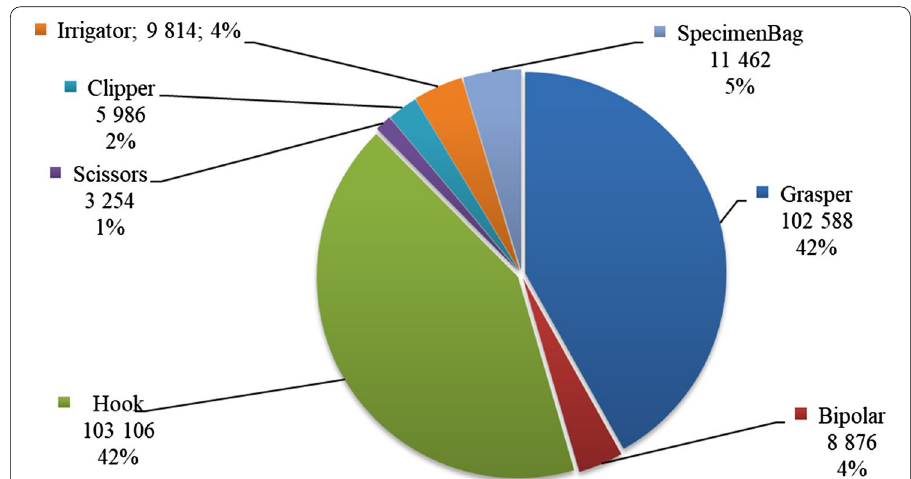
Fig. 10 Dataset statistics. Number of frames and percentage of presence for each tool in the Cholec80